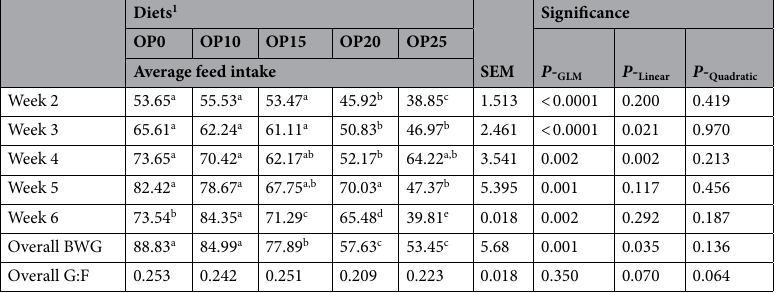
Table 3. Effects of incremental levels of dietary olive pomace on growth performance in Jumbo quail. a– e In a row, means with common superscripts do not differ ( p < 0.05). 1 Diets: OP0 a standard grower diet without olive pomace, OP10 a standard grower diet with 100 g/kg olive pomace, OP15 a standard grower diet with 150 g/ kg olive pomace, OP20 a standard grower diet with 200 g/kg olive pomace, OP25 a standard grower diet with 250 g/kg olive pomace.